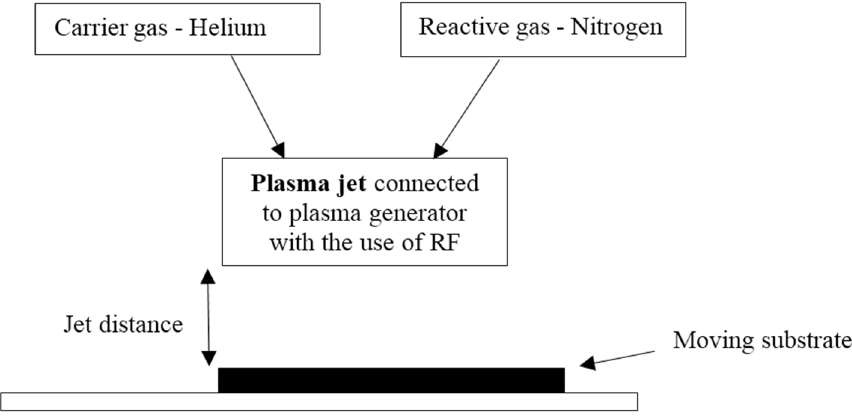
Figure 2. Schematic diagram of the Atmospheric pressure plasma (APP) treatment.